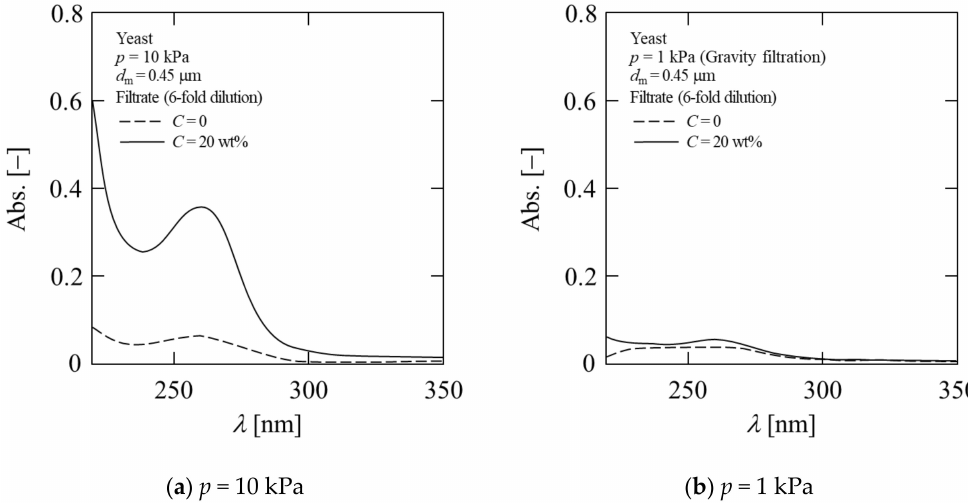
Figure 8. Spectrum of filtrate: ( a ) p = 10 kPa; ( b ) p = 1